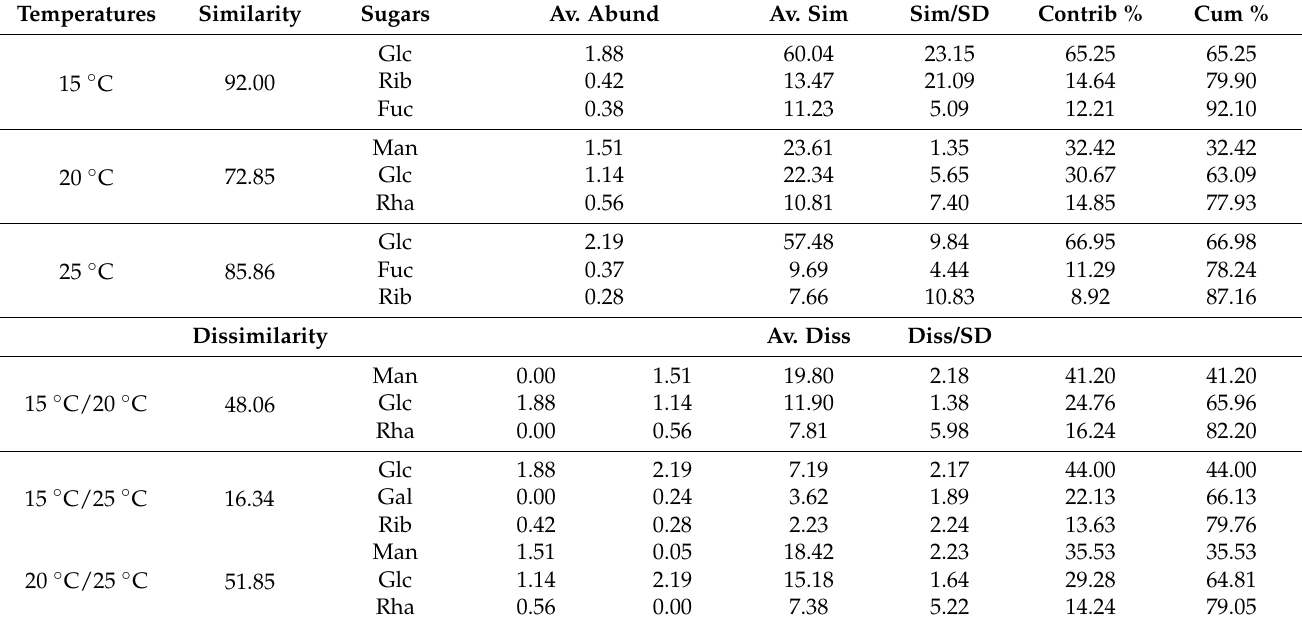
Table 9. SIMPER analyses showing the average similarity and dissimilarity among temperatures, related with n-MDS analysis. Temperatures